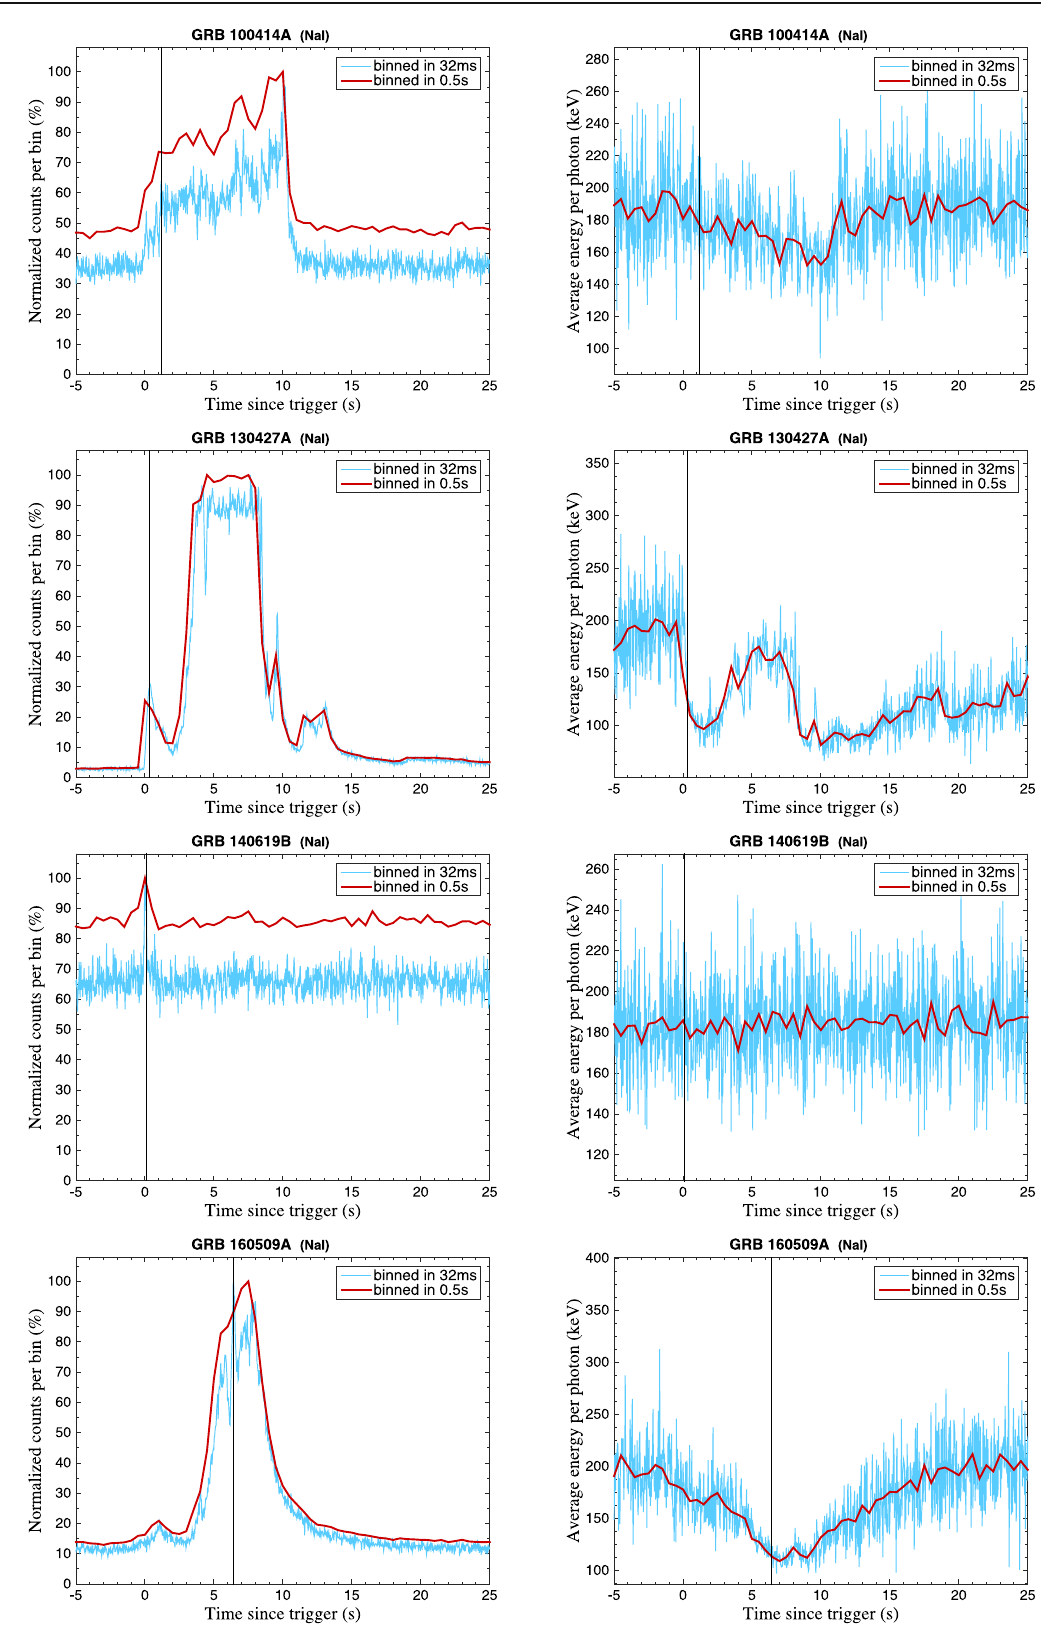
Fig. 18 Curves in Set-NaI (part 2): light curves and average energy curves of GBM NaI